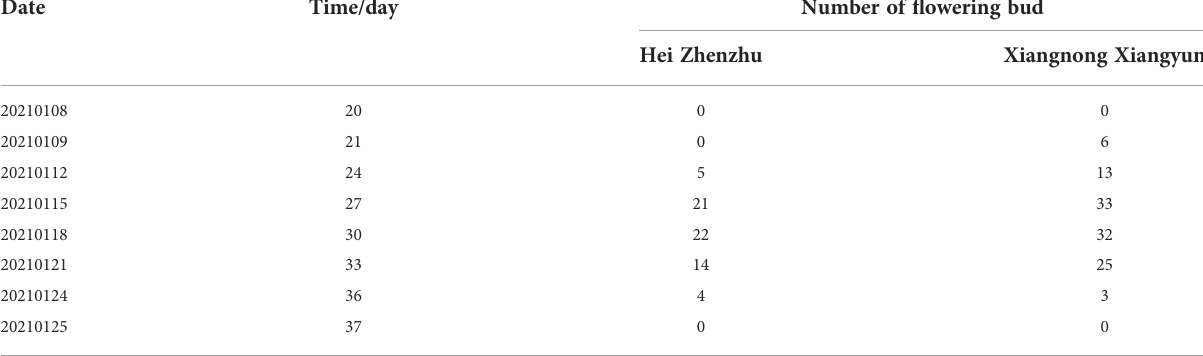
TABLE 2 Number of fl ower buds and time to bud emergence under normothermic (25°C) culture after low-temperature